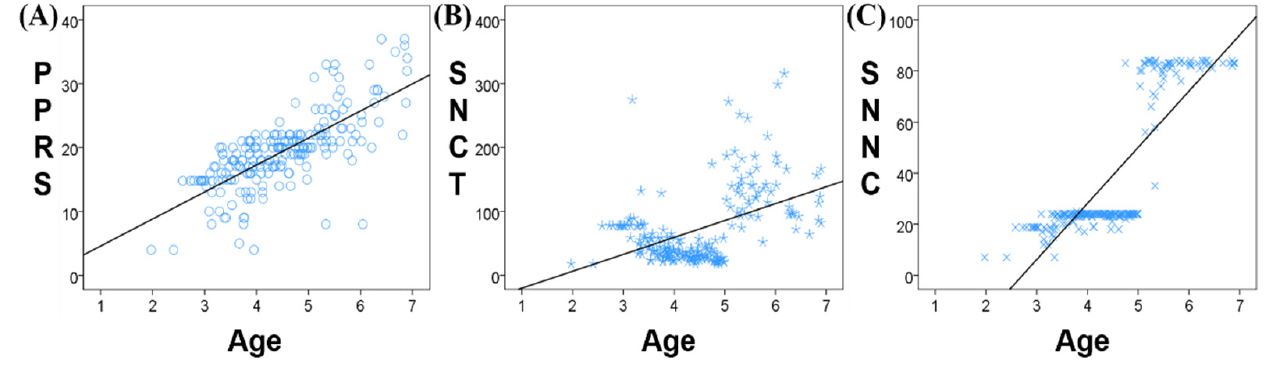
Figure 2. Correlation between age and neuropsychological assessment scores (( A ) PPRS; ( B ) SNCT; ( C ) SNNC).